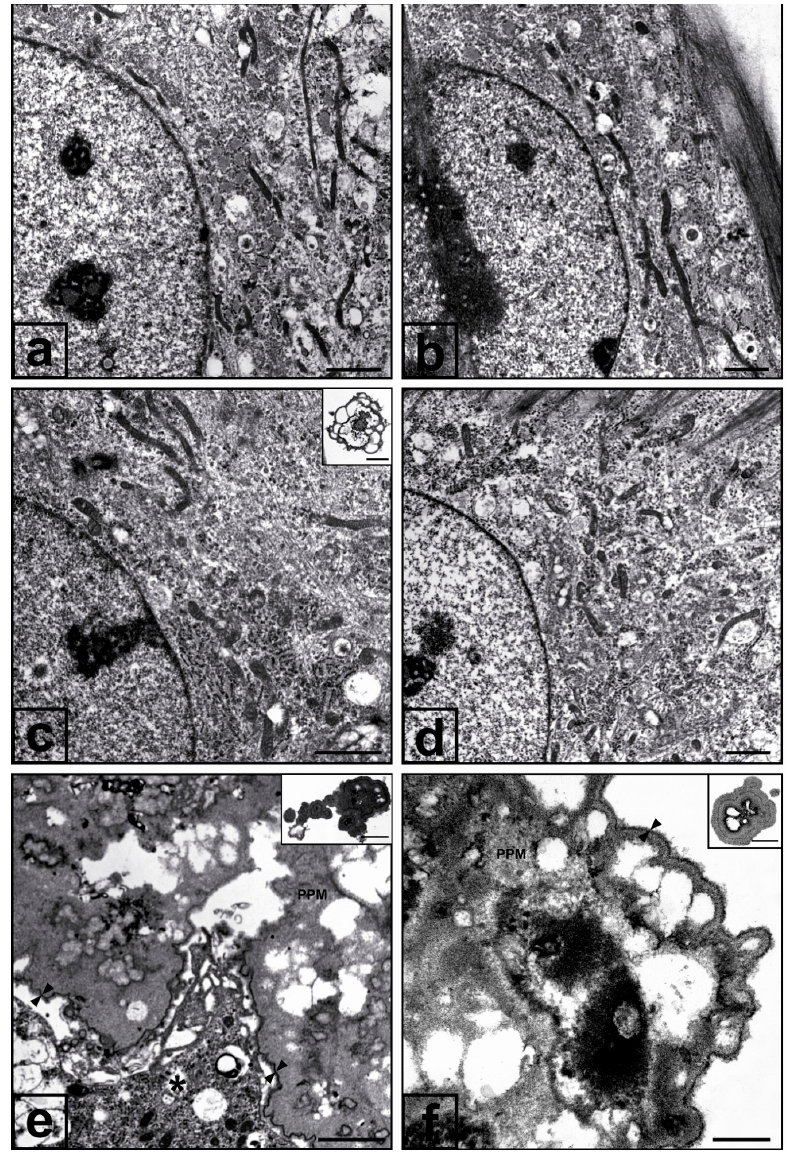
Figure 4. Transmission electron microscopy micrographs of cultured AVICs. ( a ) AVIC from a 6 ‐ day ‐ long control culture showing normal features, including well preserved organelles. ( b ) AVIC from